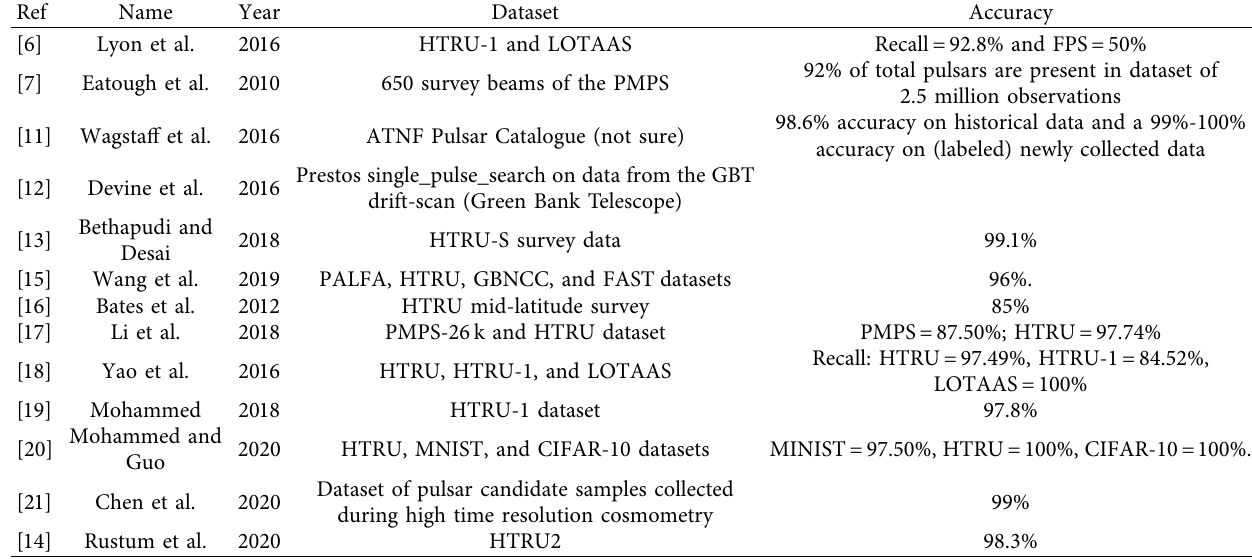
Table 1: Summary of related work.